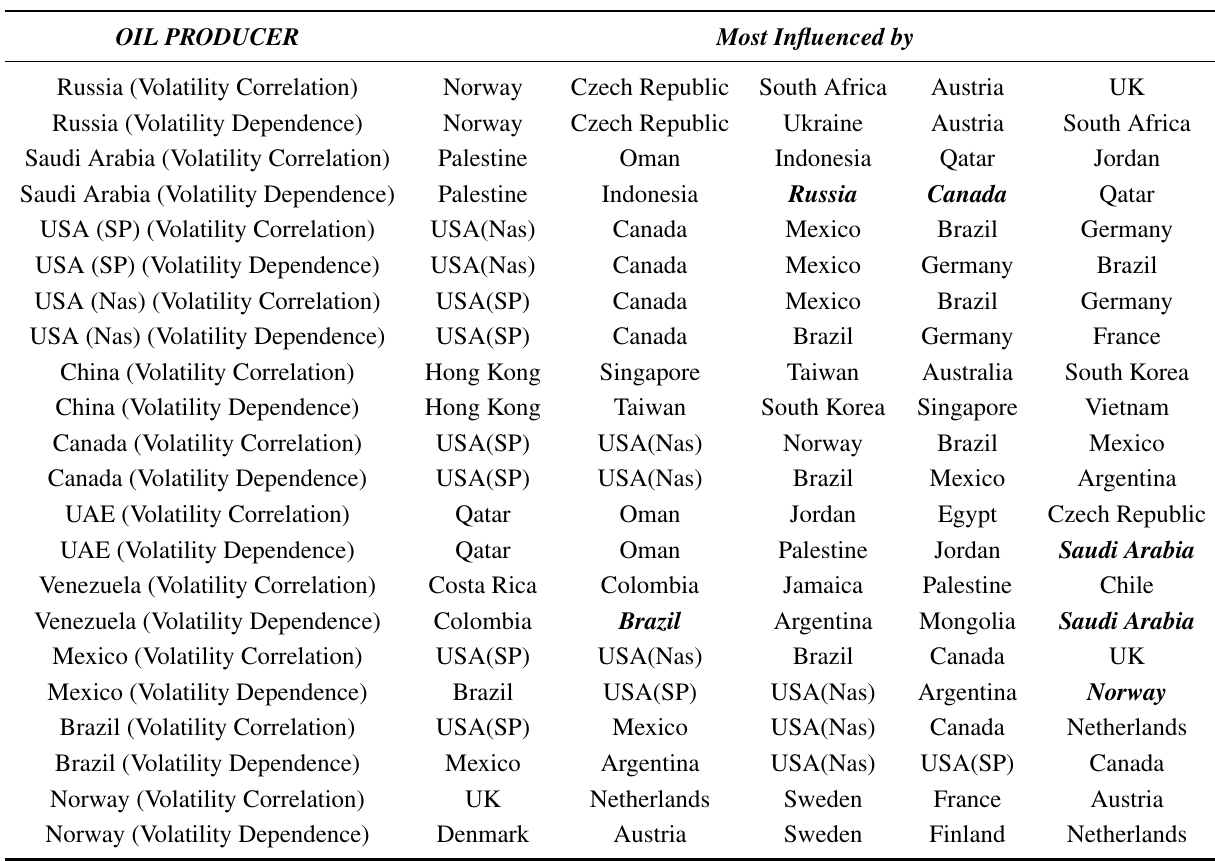
Table 4. Top five contributors to volatility correlation and to volatility dependency for major oil producing nations. In bold are those countries that appear in the dependency but not in the correlation